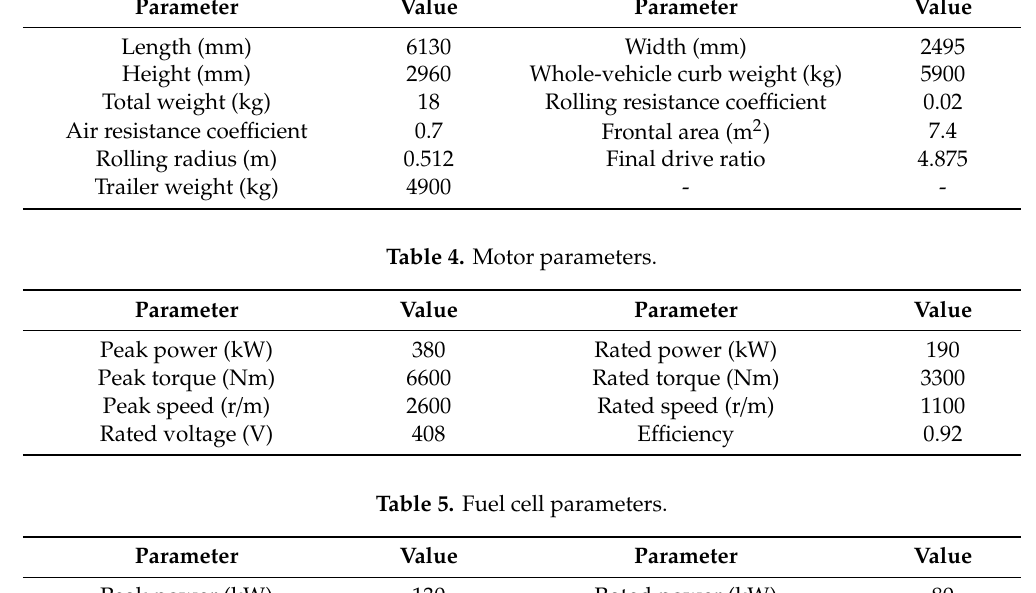
Table 4. Motor parameters.